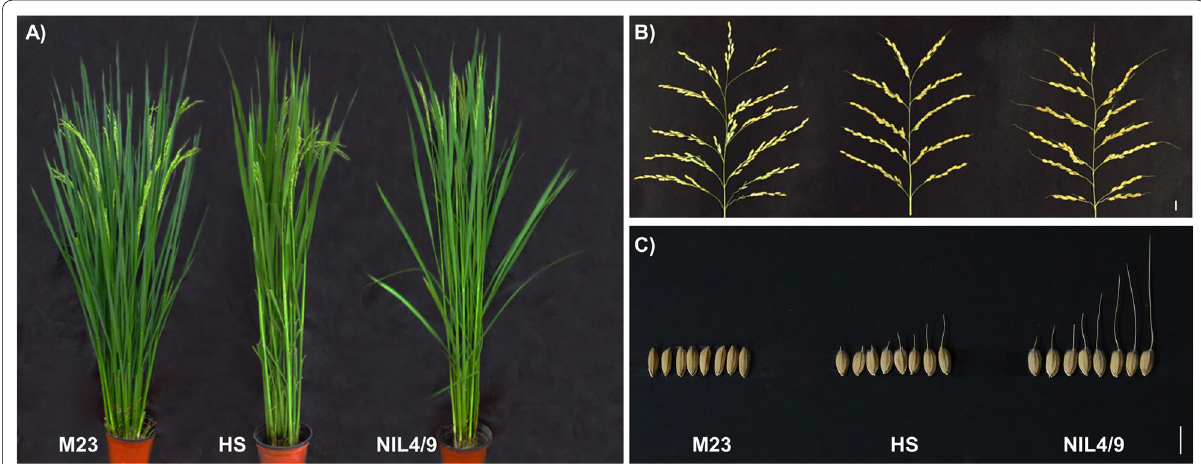
Fig. 1 Phenotypic characterization of parental lines. A Plant morphology, B panicle type, and C awn length of Milyang23 (M23), Hwaseong (HS), and NIL4/9. Scale bar 1 =